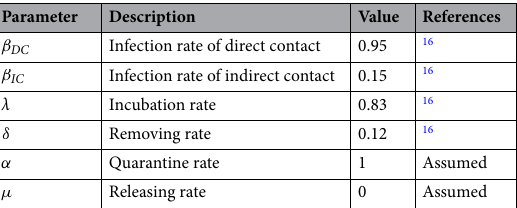
Table 1. Description and value of the parameters in the